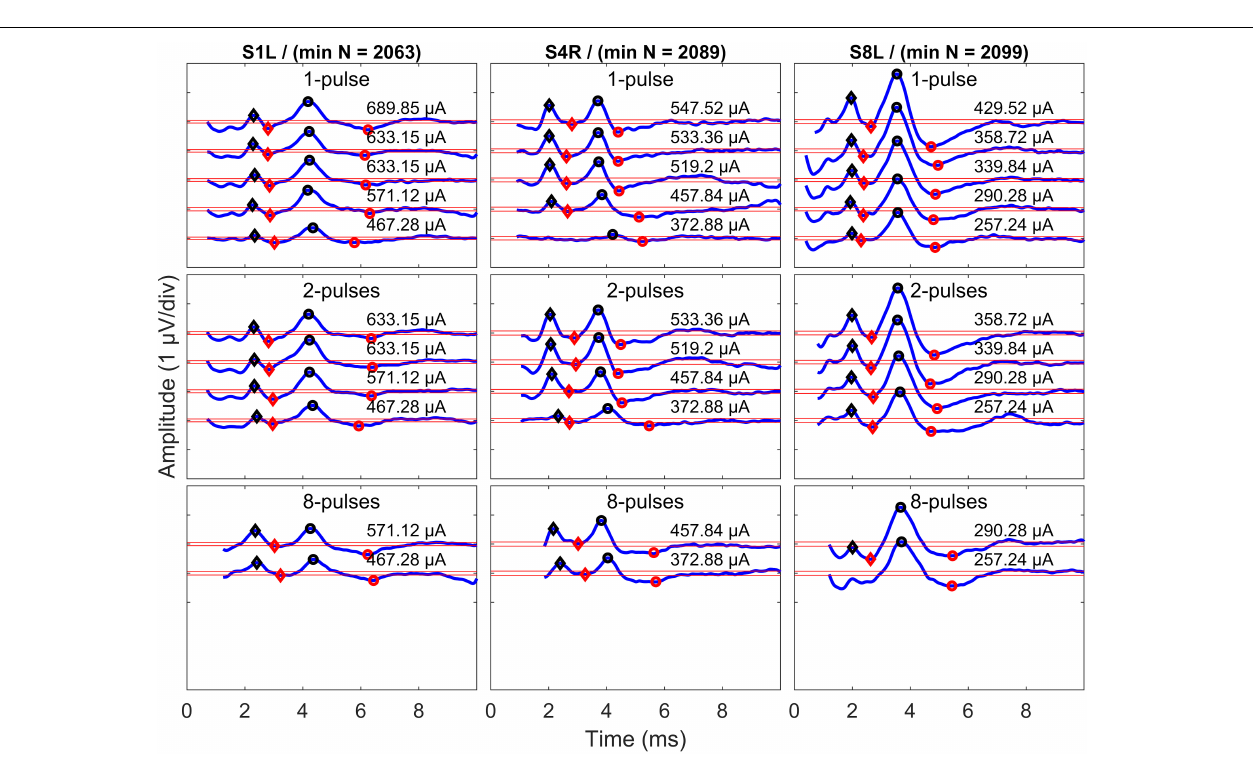
FIGURE 5 | Exemplary final eABRs for three subjects (columns) in multi-pulse conditions (rows). The stimulation amplitudes and the number of pulses are indicated in each panel. Significant peaks and troughs of eIII are marked with filled black and red diamonds, respectively. Peaks and troughs of eV are shown with filled black √ and red circles, respectively. Horizontal red lines indicate ± 2 ˆ σ RN . The minimum number of epochs used for averaging (min N) is indicated for each subject.